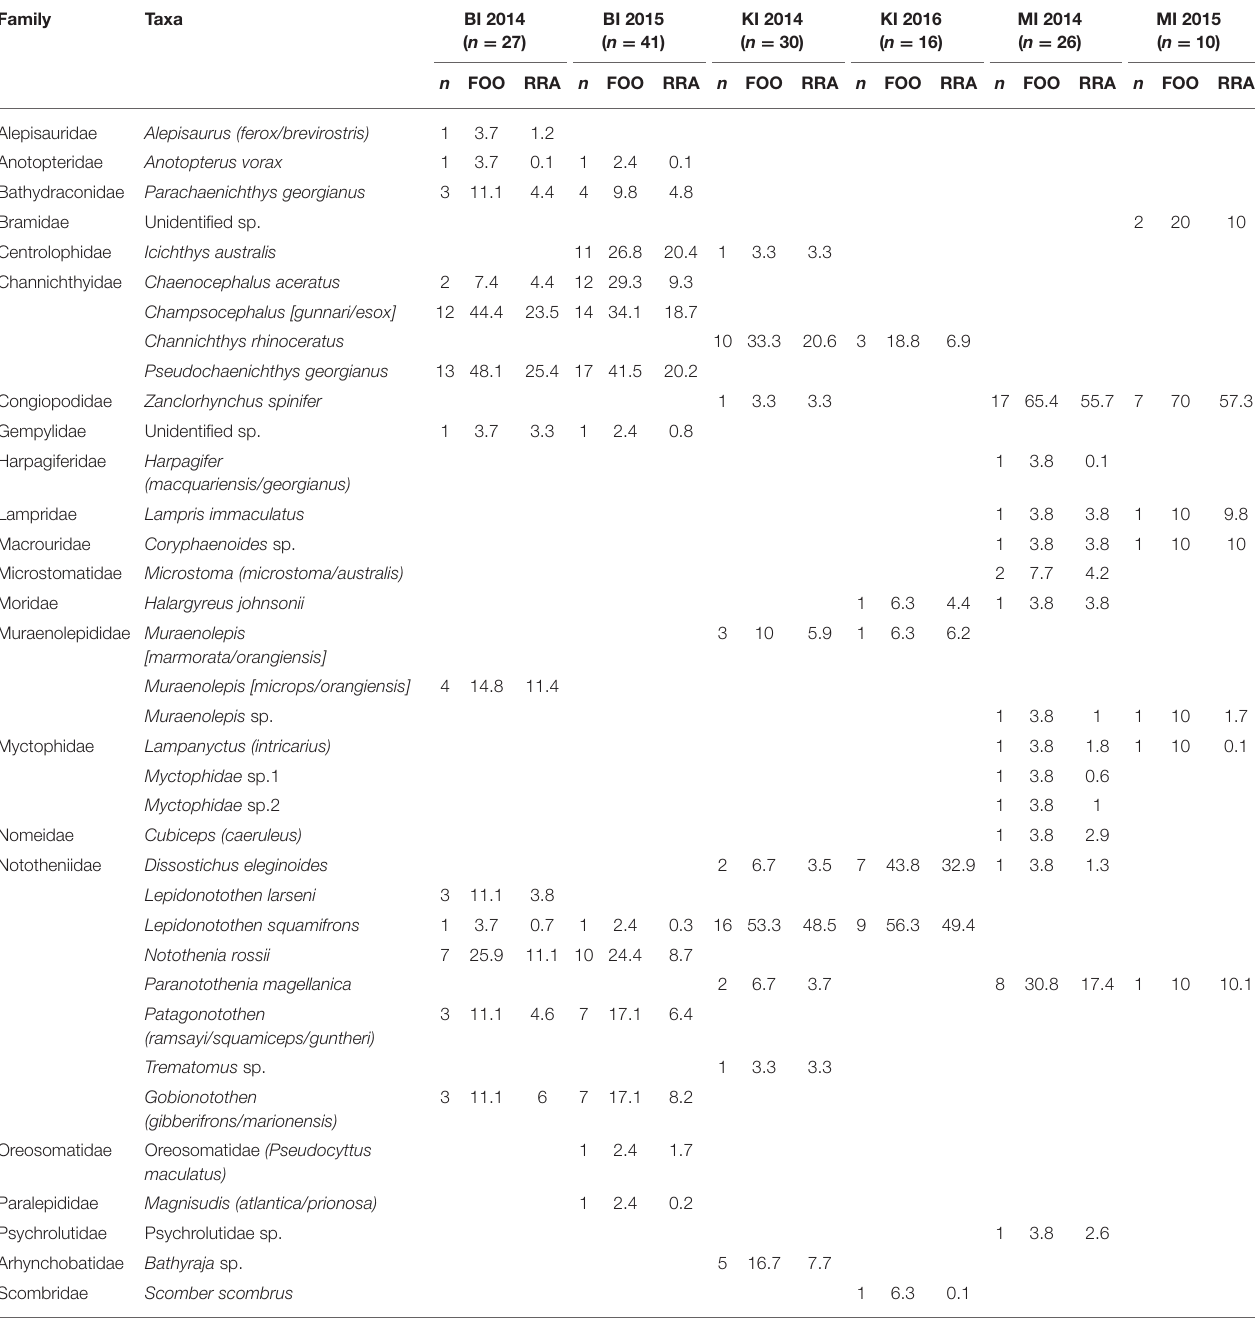
TABLE 6 | Fish prey of black-browed albatrosses at Bird Island, South Georgia UK (BI); Iles Kerguelen, France (KI) and Macquarie Island, Australia (MI). Family